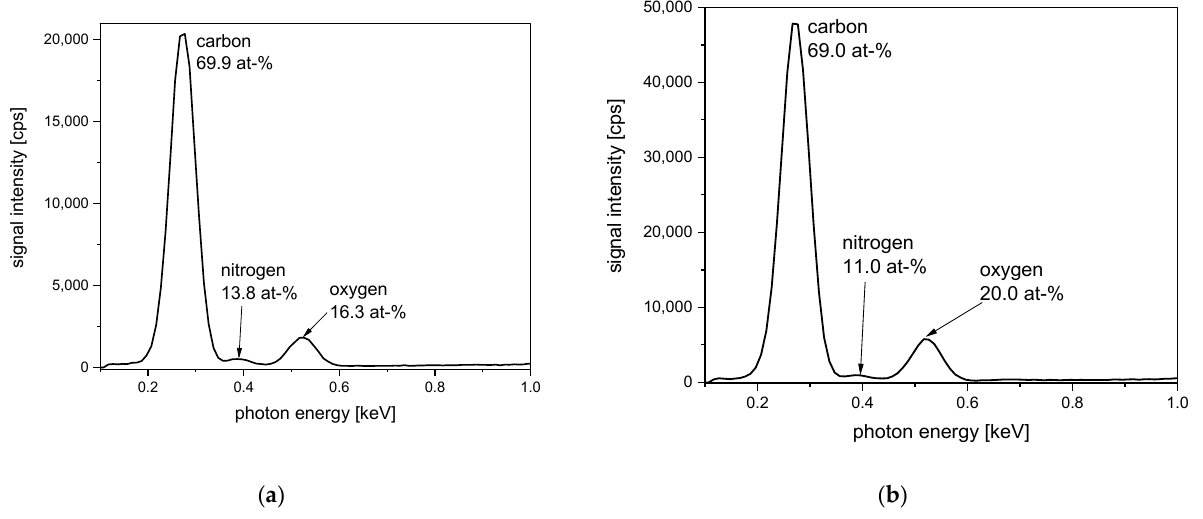
Figure 17. EDS spectra of different flame-retardant fiber materials: ( a ) m-aramid (Nomex) taken from a non-woven filter material; ( b ) polyamideimide sample taken from a polymer bullet.